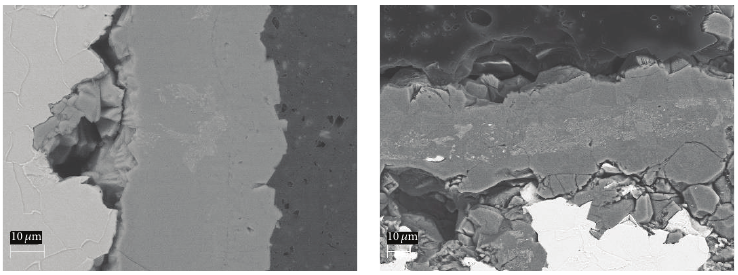
Figure 5: Carbide bands in the scale of B-A